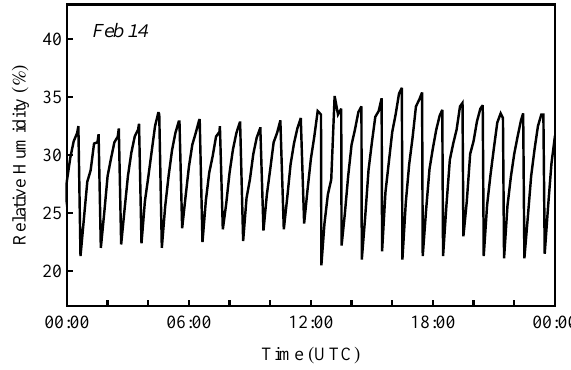
Fig. 3. Relative humidity in the laminar-flow aerosol sampling line using the dryer described by Tuch et al. (2009). The dryer con- sists of two diffusion dryers (silica gel), and the aerosol flow is di- verted into one dryer while the second one is regenerated. When the threshold RH for regeneration is reached, the aerosol flow is di- verted to that dryer. The method of regeneration is a dry-air flow obtained from a compressor.